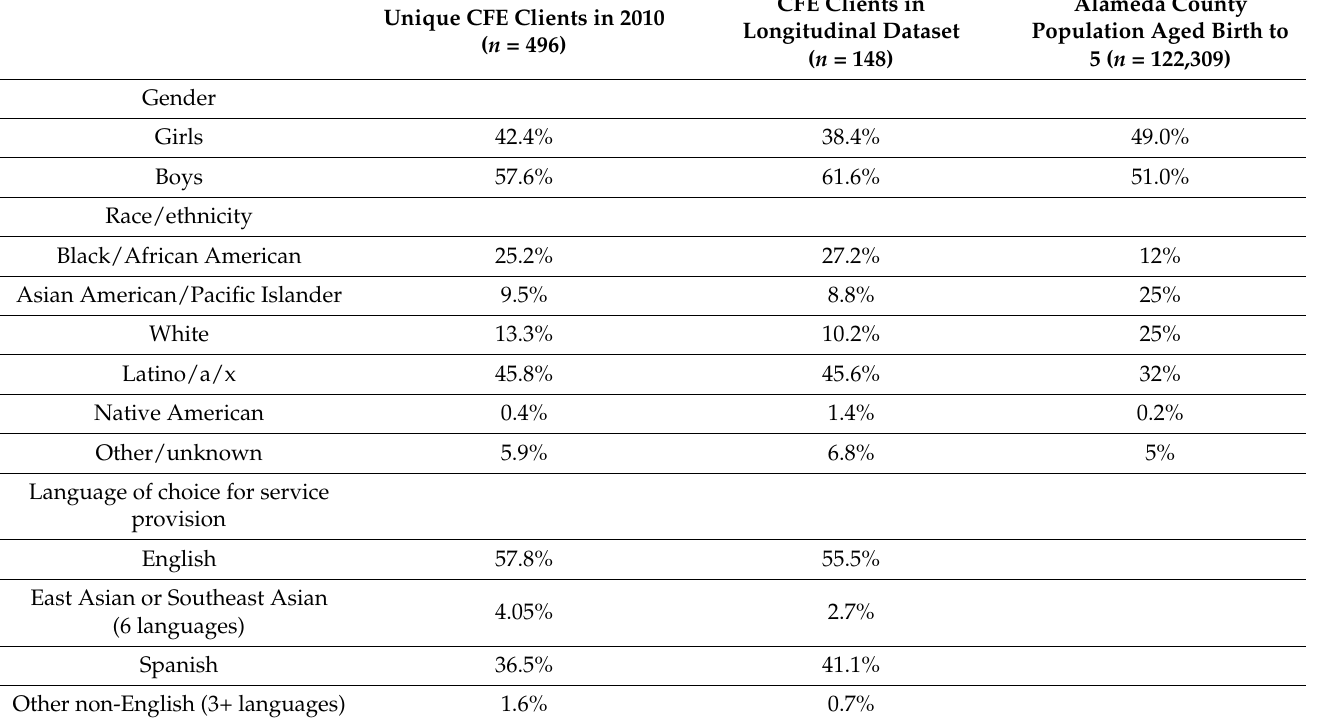
Table 2. Sample characteristics of children birth to 5 with social, emotional and behavioral concerns served by MediCal Mental Health Providers in 2010 ( n = 496), in comparison to the general Alameda County birth-5